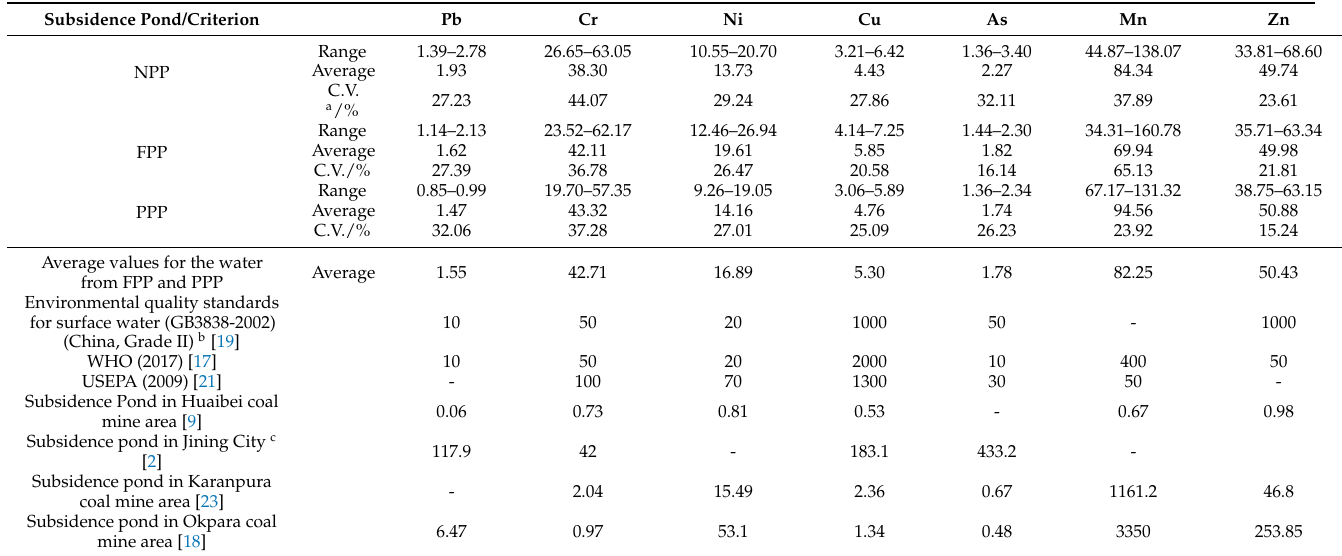
Table 1. The statistics of heavy metals concentrations in different subsidence ponds